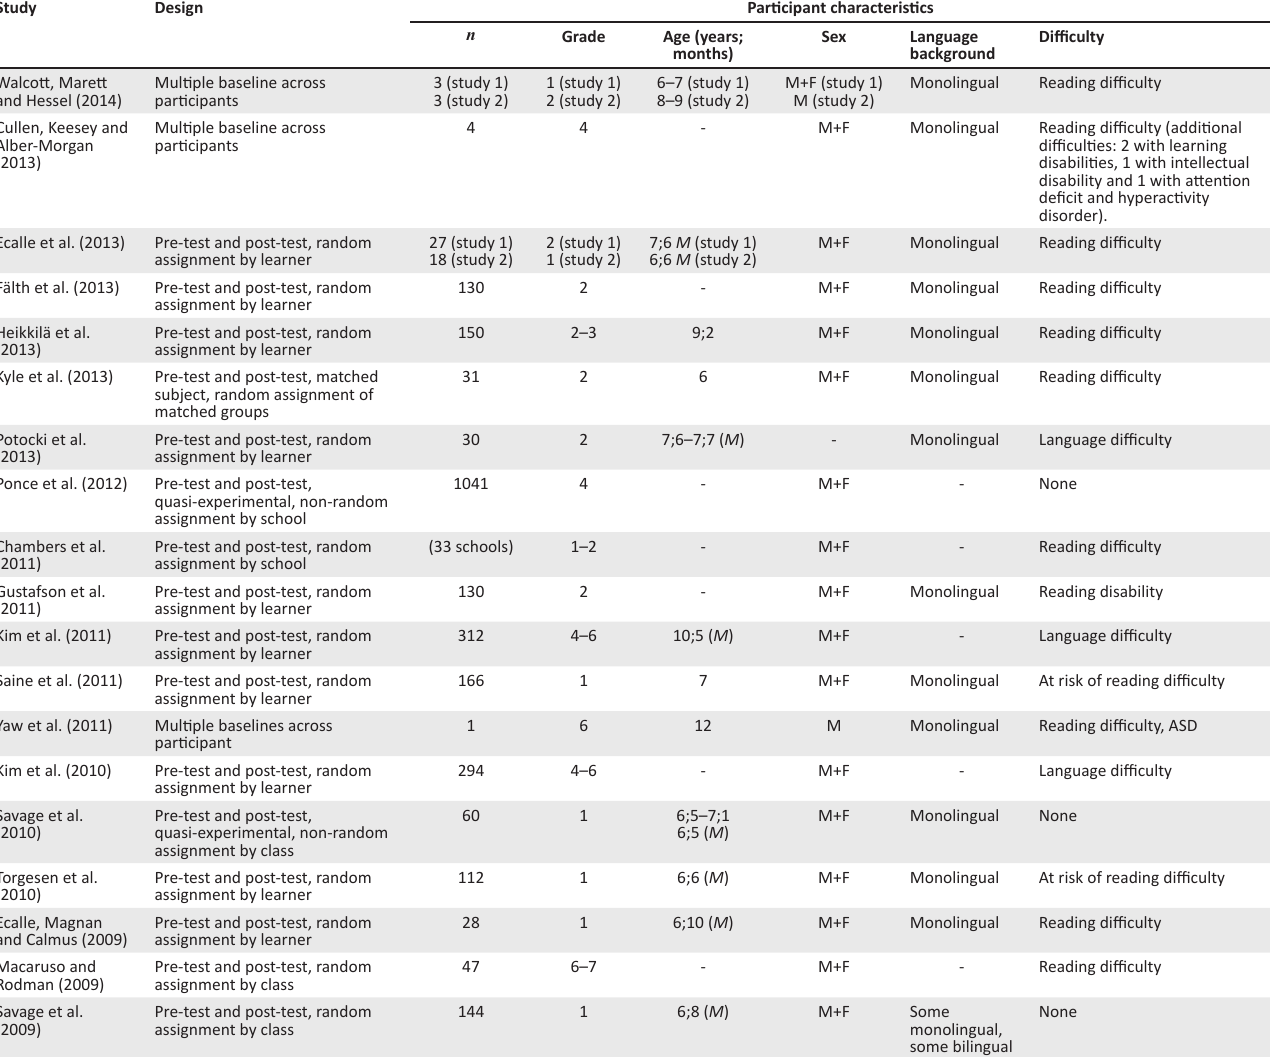
TABLE 1-A1 (Continues...): Design and participant characteristics of studies included in the information and communication technology-based reading intervention scoping review. Study